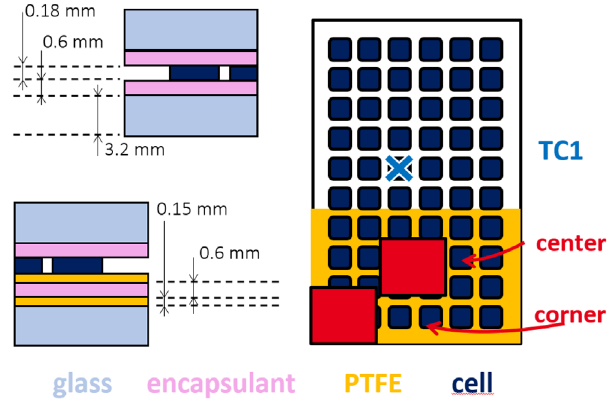
Fig. 2. Cross-section (not to scale) of the developed PV modules. It has two parts; the top one includes a thermocouple (TC1); the bottom one has two added PTFE layers. These layers allow the extraction of the encapsulant after lamination. It will be helpful for Sections 3 and 4.